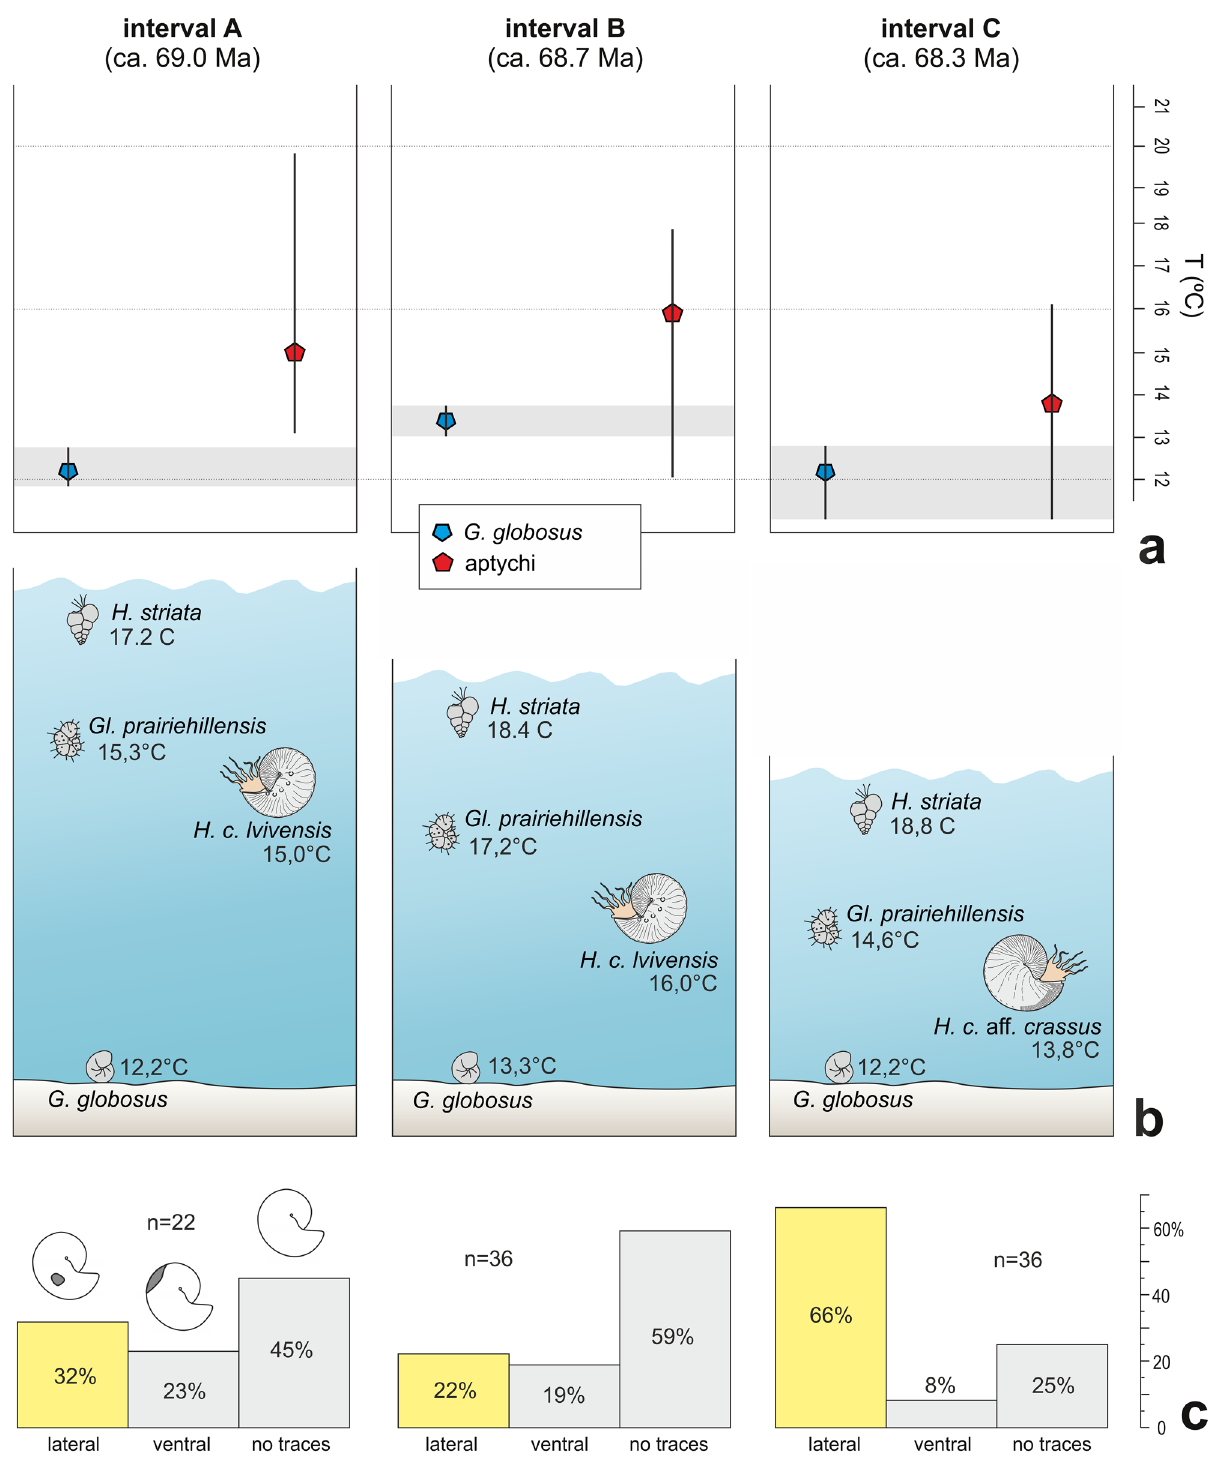
Figure 4. A combination of stable isotope and palaeotemperature data from aptychi of Hoploscaphites constrictus and foraminifera with data on the predation marks preserved on moulds of H. constrictus , intervals A–C, Chełm section. ( a ) Box and whisker plots of temperature gradient traversed by the scaphitids studied (based on δ 18 O data from aptychi). Each box represents the mean value and whiskers are extended between the maximum and minimum temperature values. Grey shaded areas represent putative bottom waters gradient based on δ 18 O data from the benthic foraminifer G. globosus . ( b ) Positions of taxa studied in the water column of the shallowing Maastrichtian sea, based on mean palaeotemperatures from δ 18 O data. ( c ) Incidence of predation traces on H. constrictus (see SI-Fig. 8). H. , Heterohelix ; Gl. , Globigerinelloides ; G. , Gyroidinoides ; C. , Cibicidoides ; H. c ., Hoploscaphites constrictus